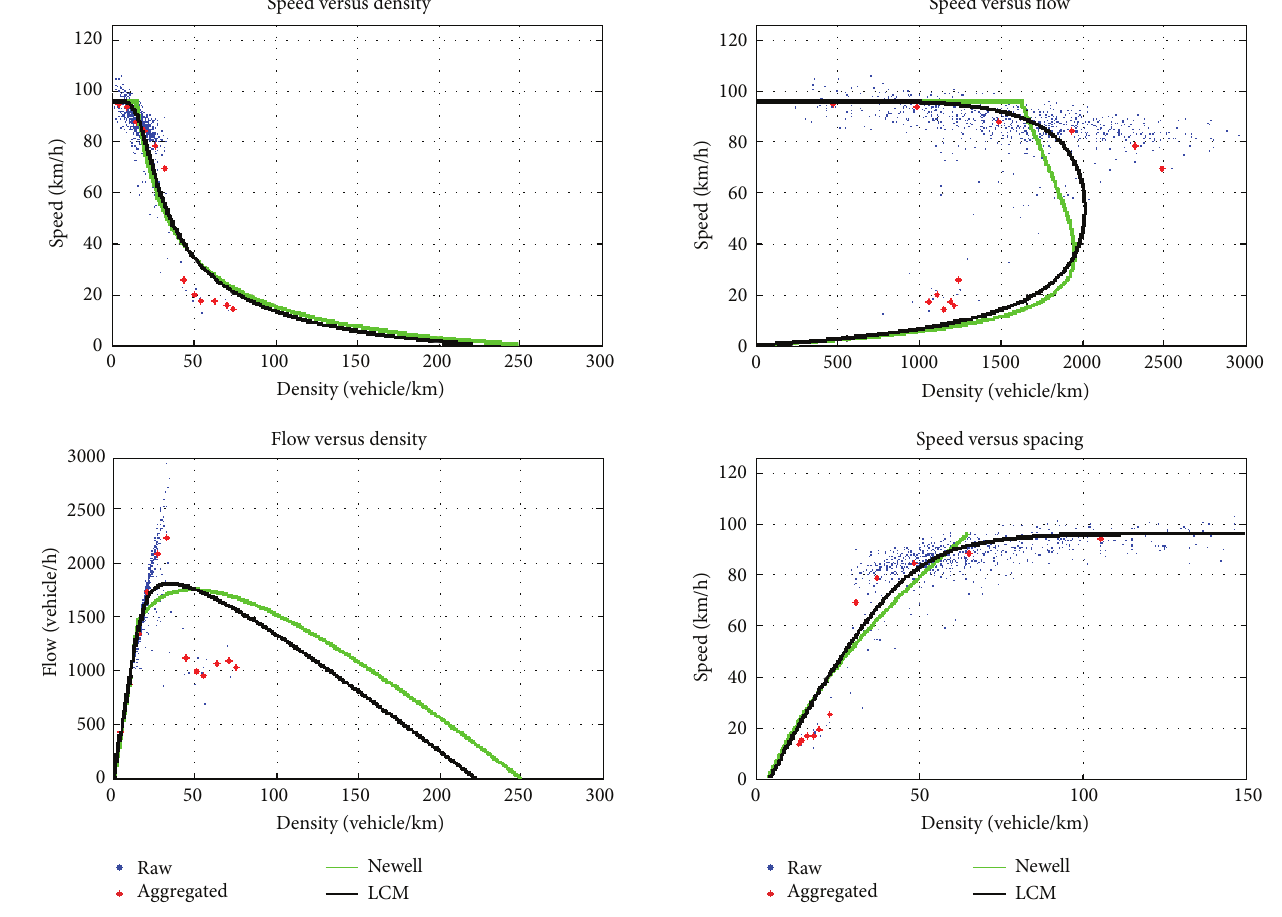
Figure 7: LCM and Newell’s model calibrated by bisection